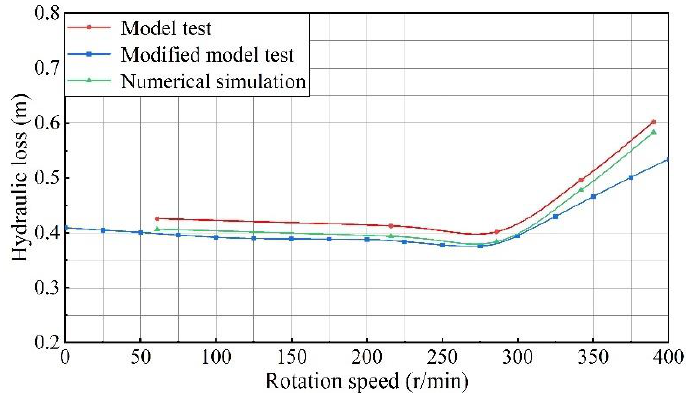
Figure 14. Model test results of hydraulic loss of outlet conduit under different inlet water rotation speeds.